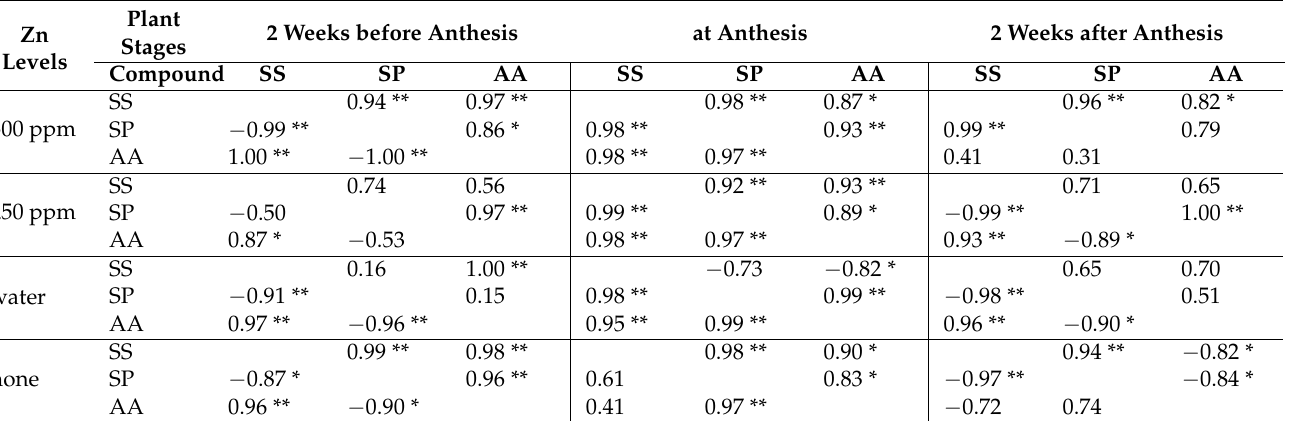
Table 3. The correlations among soluble sugars (SS), soluble proteins (SP), and free amino acids (AA) for Zn levels under drought (above) and irrigation (below diagonal) at different plant stages. at Anthesis